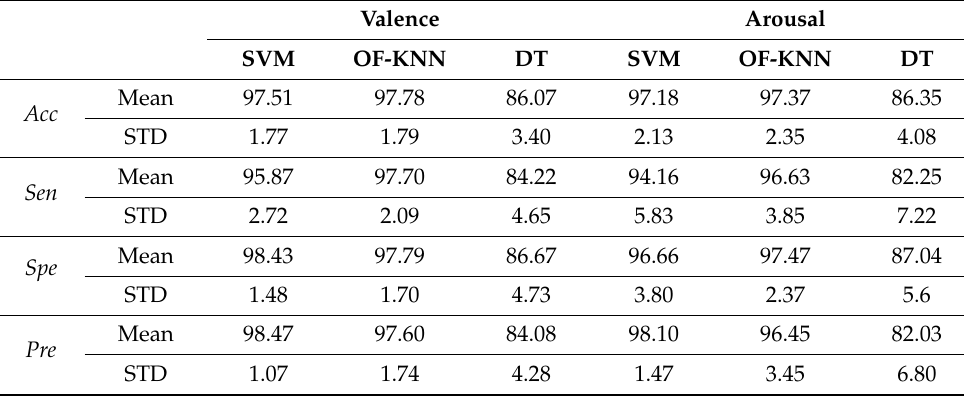
Table 5. Performance estimation for time-domain features (%).